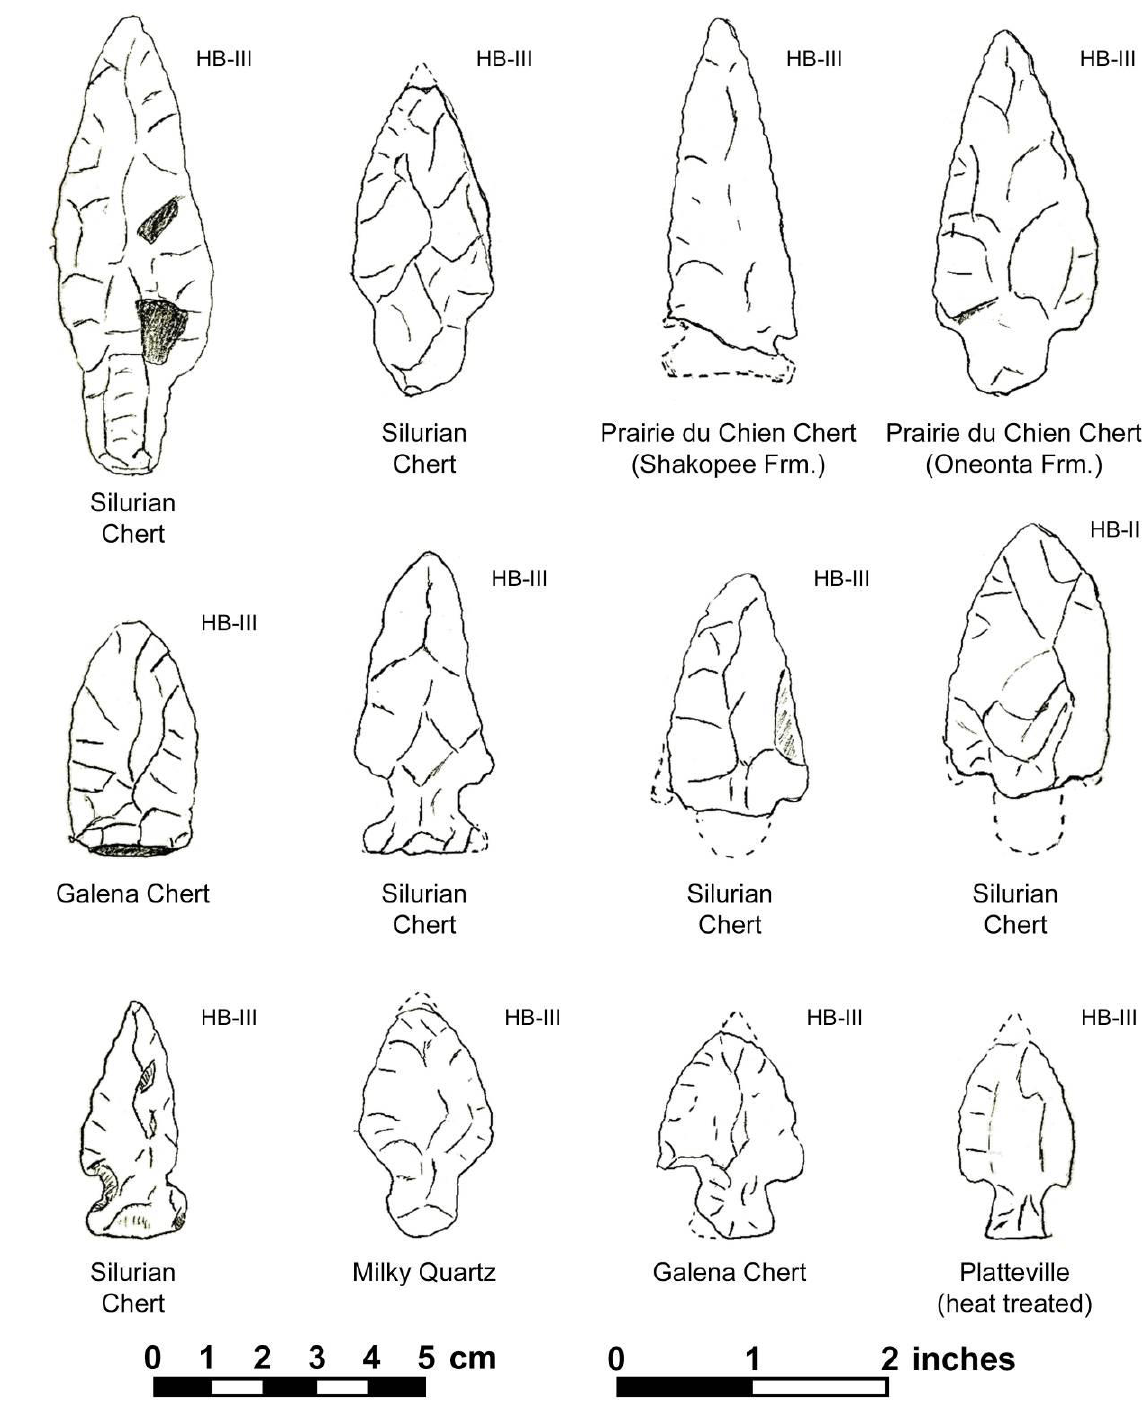
Figure 18. Sketches of artefacts from an area land owner's personal collection of lithic points found approximately 1.5 kilometers north of the Starman site. All are mid to late Archaic period in age (3000-1000 BCE) and made from cherts typical to southeastern Wisconsin. Well over 200 points from two private collections were examined with over 95% dating pre-1500